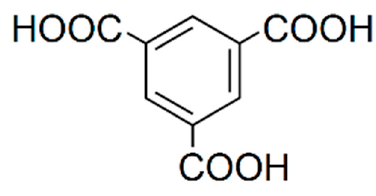
Figure 3. 1,3,5-benzenetricarboxylic acid (BTC).